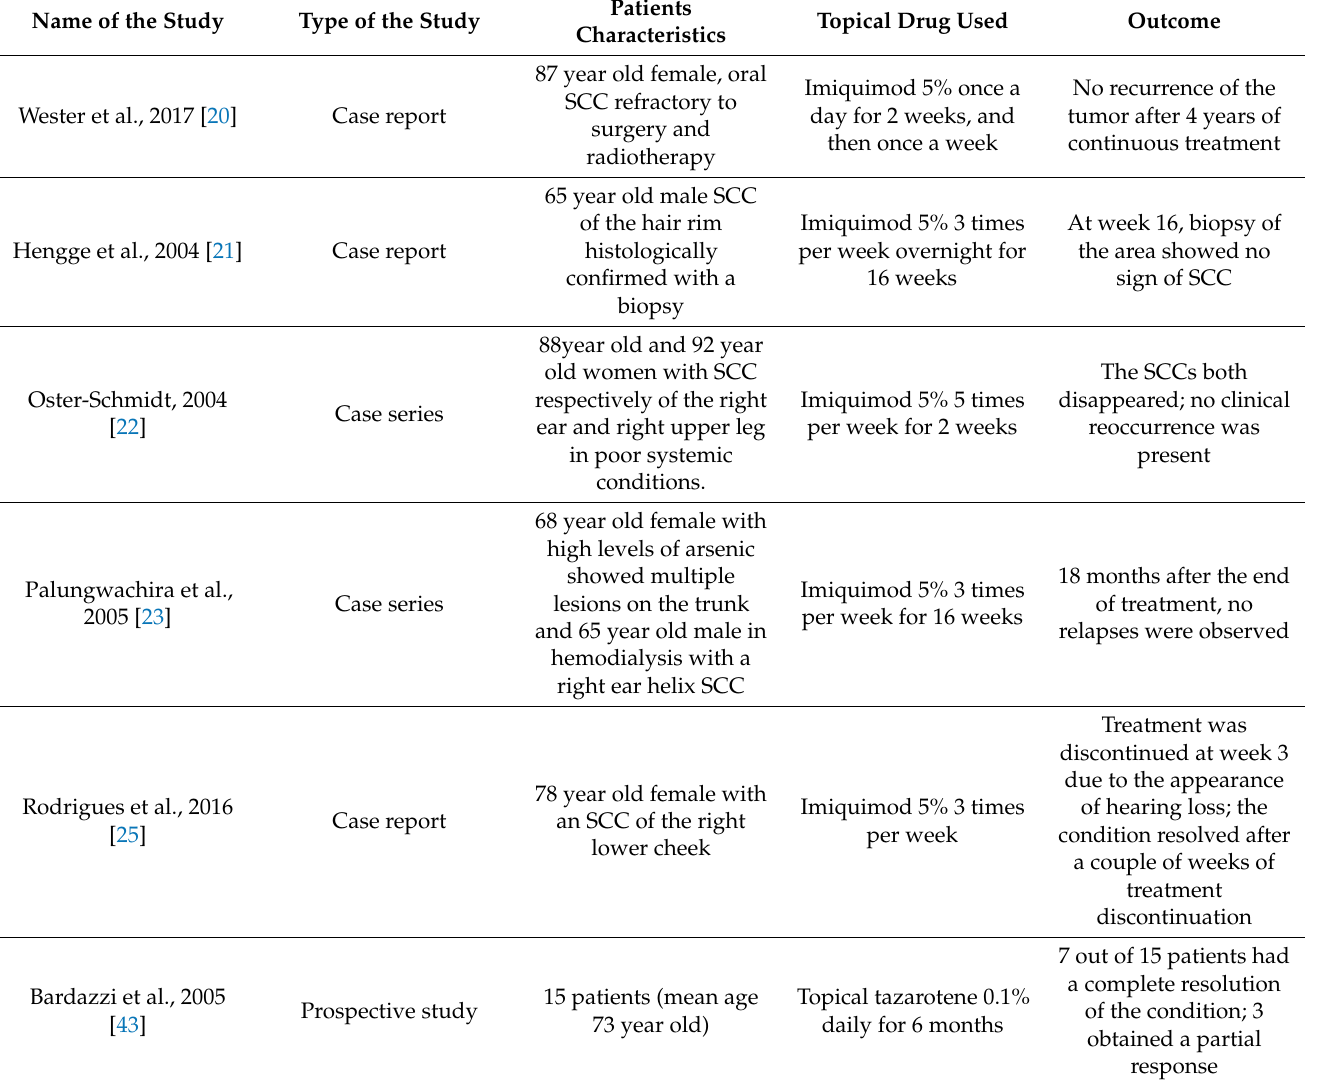
Table 2. Studies included in the